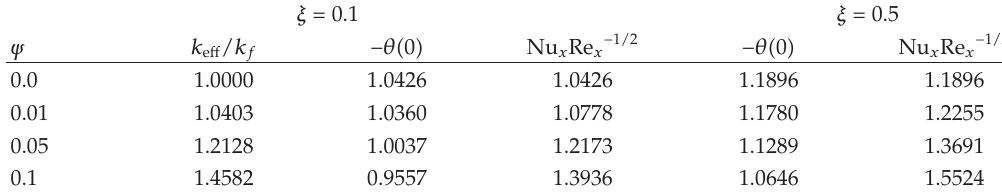
Table 3: Water-Cu nanofluid (cid:5) Pr (cid:8) 6.2, m (cid:8) 1, p (cid:8) 1, ∧ (cid:8) 0 . 1 (cid:6) .